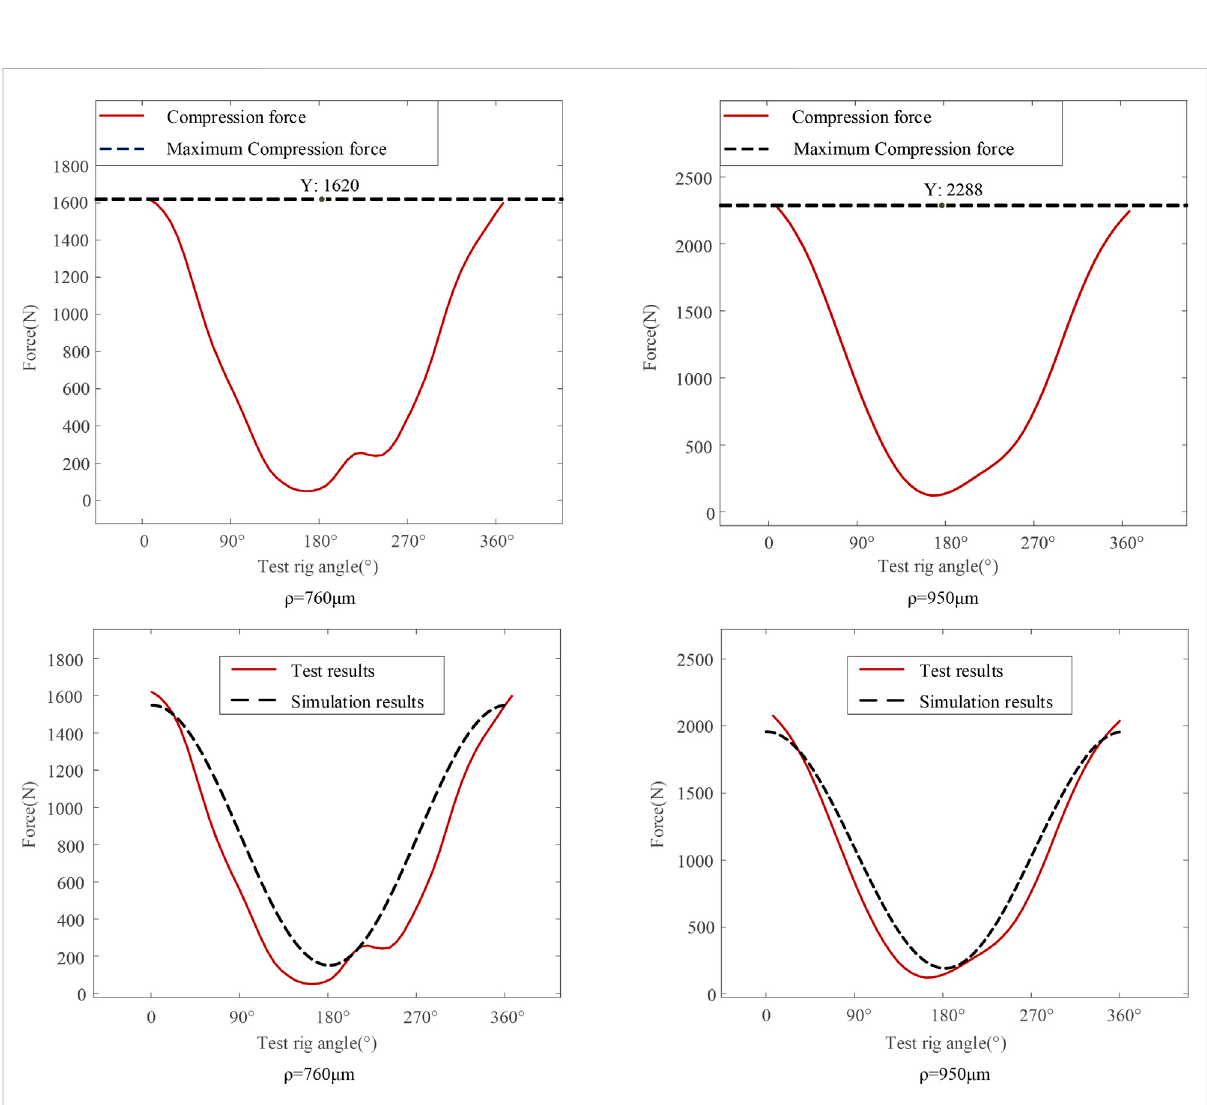
FIGURE 14 Fitted graph of the magnitude and variation of the compression force of the test setup at ρ =